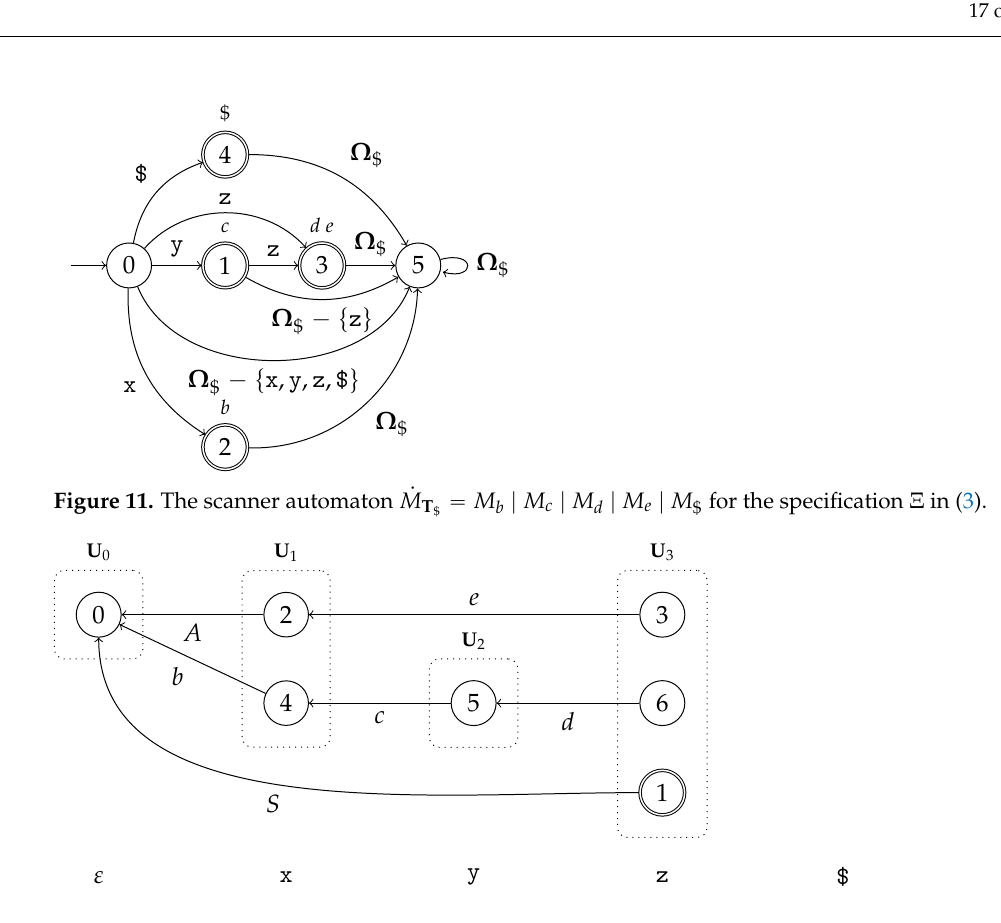
Figure 12. The GSS constructed by our architecture using the specification Ξ in (3).